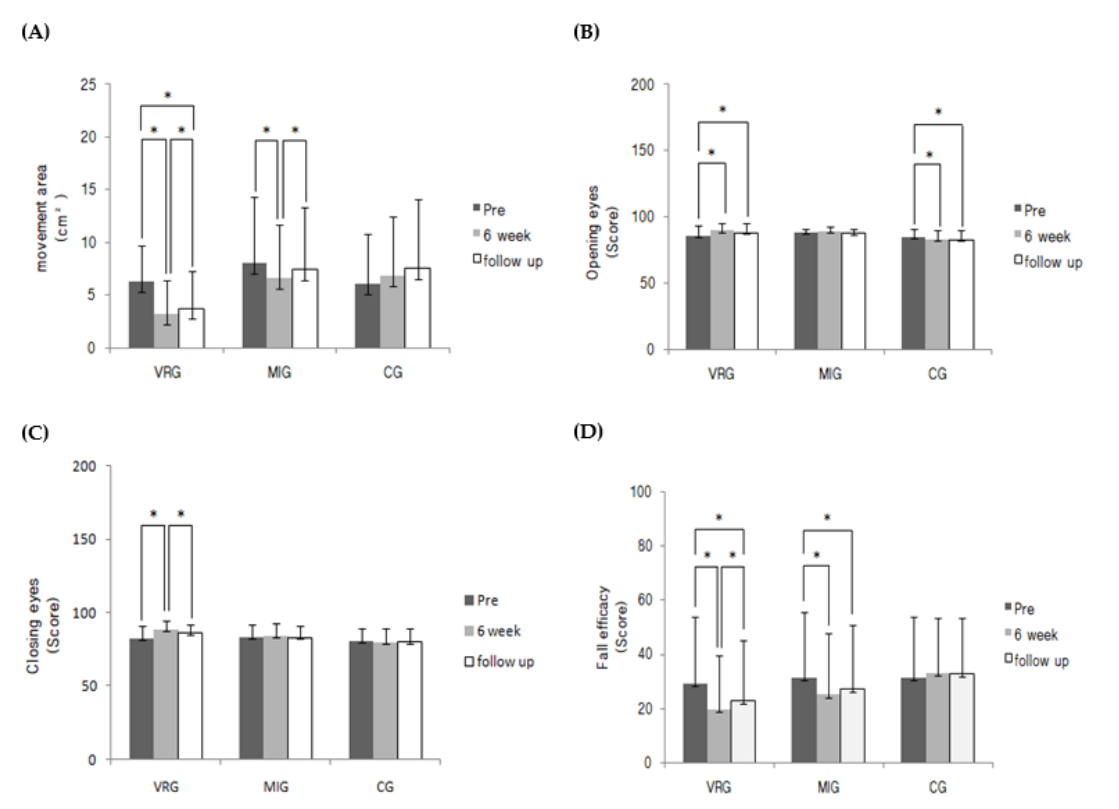
Figure 3. Comparison of each group according to the period. ( A ) Body center movement area; ( B ) Balance sensory with eyes kept open; ( C ) Balance sensory with eyes kept closed; ( D ) Falls efficacy score. * p < 0.05